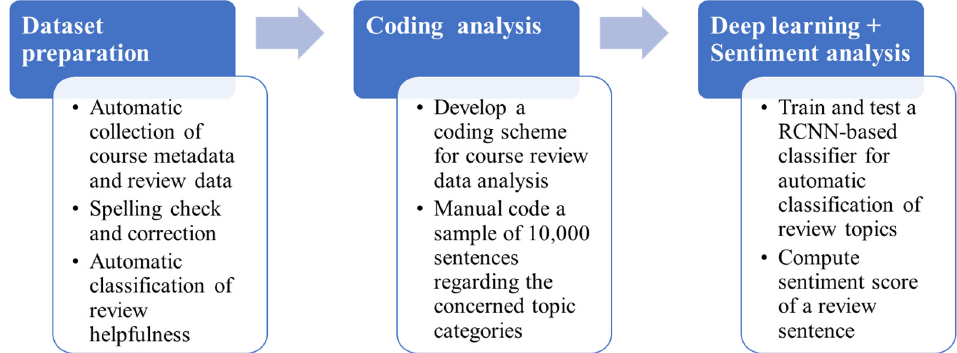
Figure 1. Architectural schema of data collection and analysis methodologies.